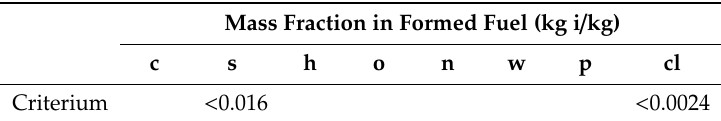
Table 6. Constraints for optimization